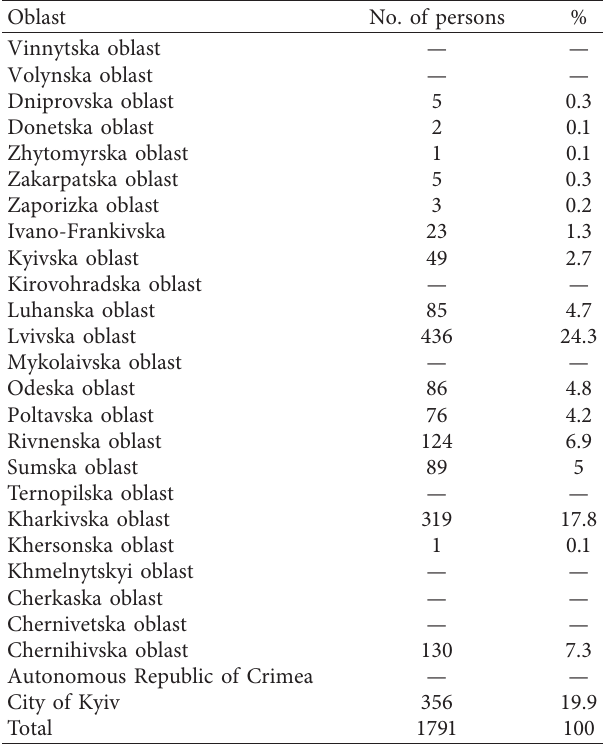
Table 4: IGSE administrators by oblasts of Ukraine.